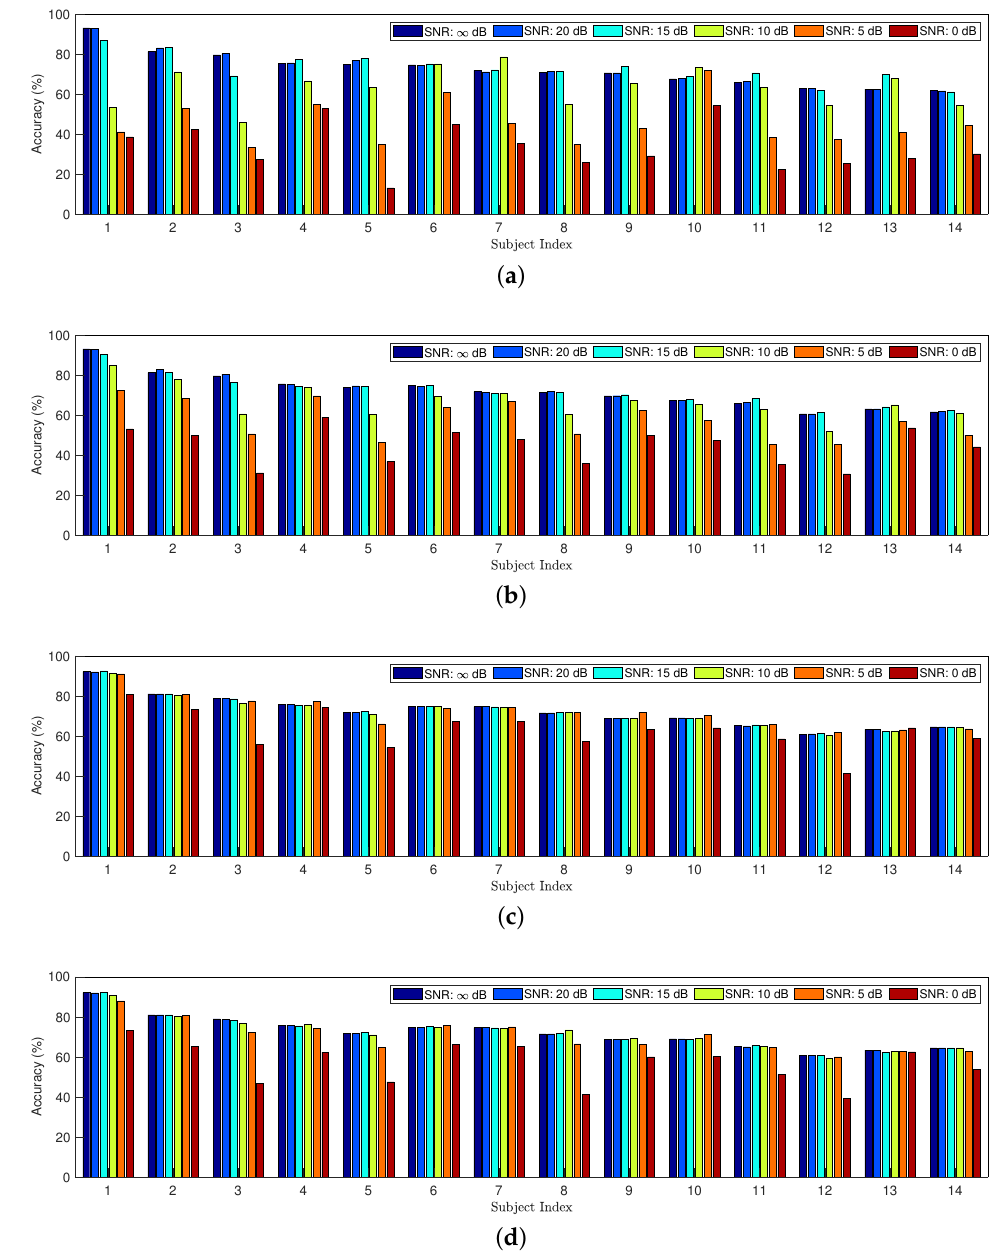
Figure 7. Average classification accuracy of fourteen subjects. ( a ) None. ( b ) Denoising. ( c ) Proposed method using ideal noise power [17]. ( d ) Proposed method using estimated noise